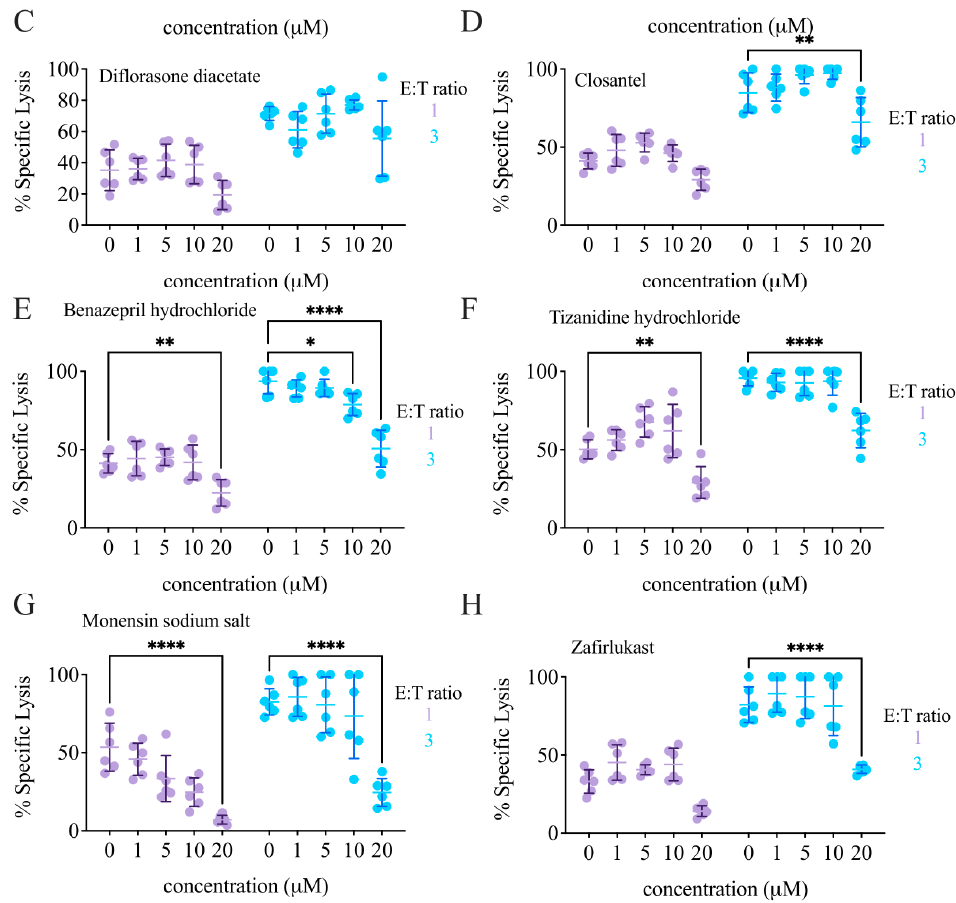
Figure 4. Colistin sulfate salt increases NK92 cytotoxicity against K562-NL. NK92 and K562-NL cells were seeded into a 96-well V bottom plate at a 1:1 or 3:1 E:T ratio with 10,000 K562-NL cells per well and treated with 1, 5, 10, and 20 μ M of the indicated drug for 5-h at 37 °C. After incubation, the supernatant was subjected to a luciferase release assay. ( A ) Colistin sulfate salt. ( B ) Nicotinamide. ( C ) Diflorasone diacetate. ( D ) Closantel. ( E ) Benazepril hydrochloride. ( F ) Tizanidine hydrochlo- ride. ( G ) Monensin sodium salt. ( H ) Zafirlukast. Each dot represents a technical replicate, experi- ments were repeated twice. Two-way ANOVA with Tukey’s multiple comparison test. *: p < 0.05, **: p < 0.01, ****: p < 0.0001.